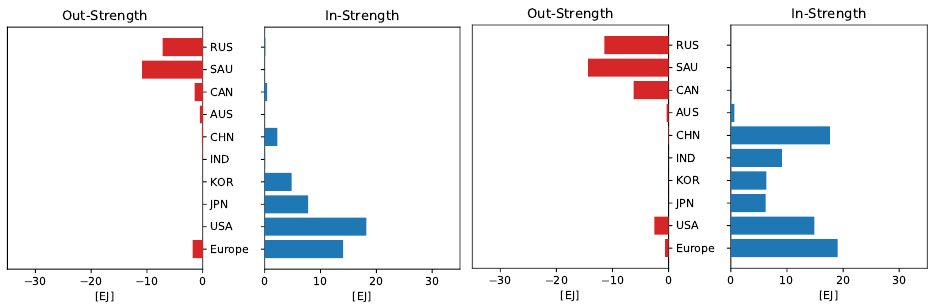
Figure 10. The change in the oil trade concentration from 2001 ( left ) to 2018 ( right